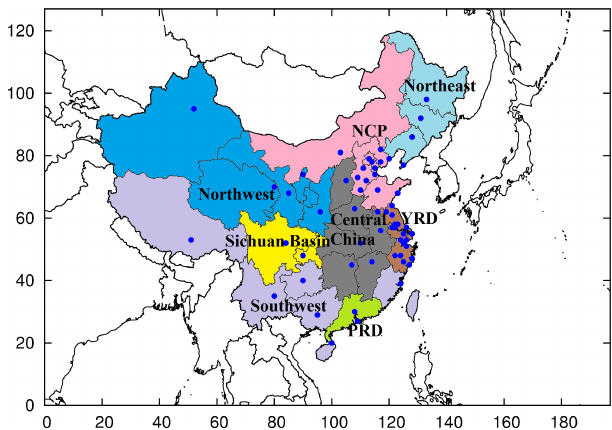
Figure 1. The WRF/CMAQ modeling domain and the regions in China. The dots represent the 60 cities where observational data are available for ensemble analysis. The x and y axis is the Lambert projection grid numbers in the west–east and south– north direction. NCP represents the North China Plain